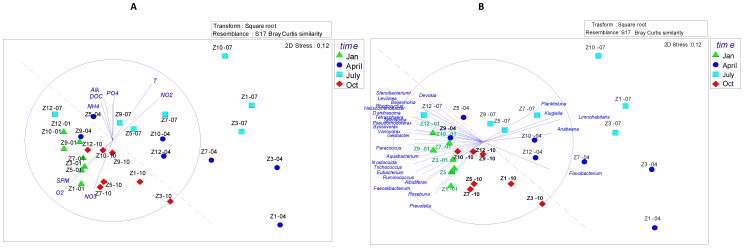
Nonmetric multidimensional scaling (MDS) plot.Environmental variables (A) and genera (B) are plotted as correlations with the river samples studied. Increasing distance between points equates to decreasing similarity in BCC. MDS plot are based on Bray-Curtis distances generated from square root transformed data. Analysis was conducted using Primer 6. Abbreviations: Jan-January, Oct-October.